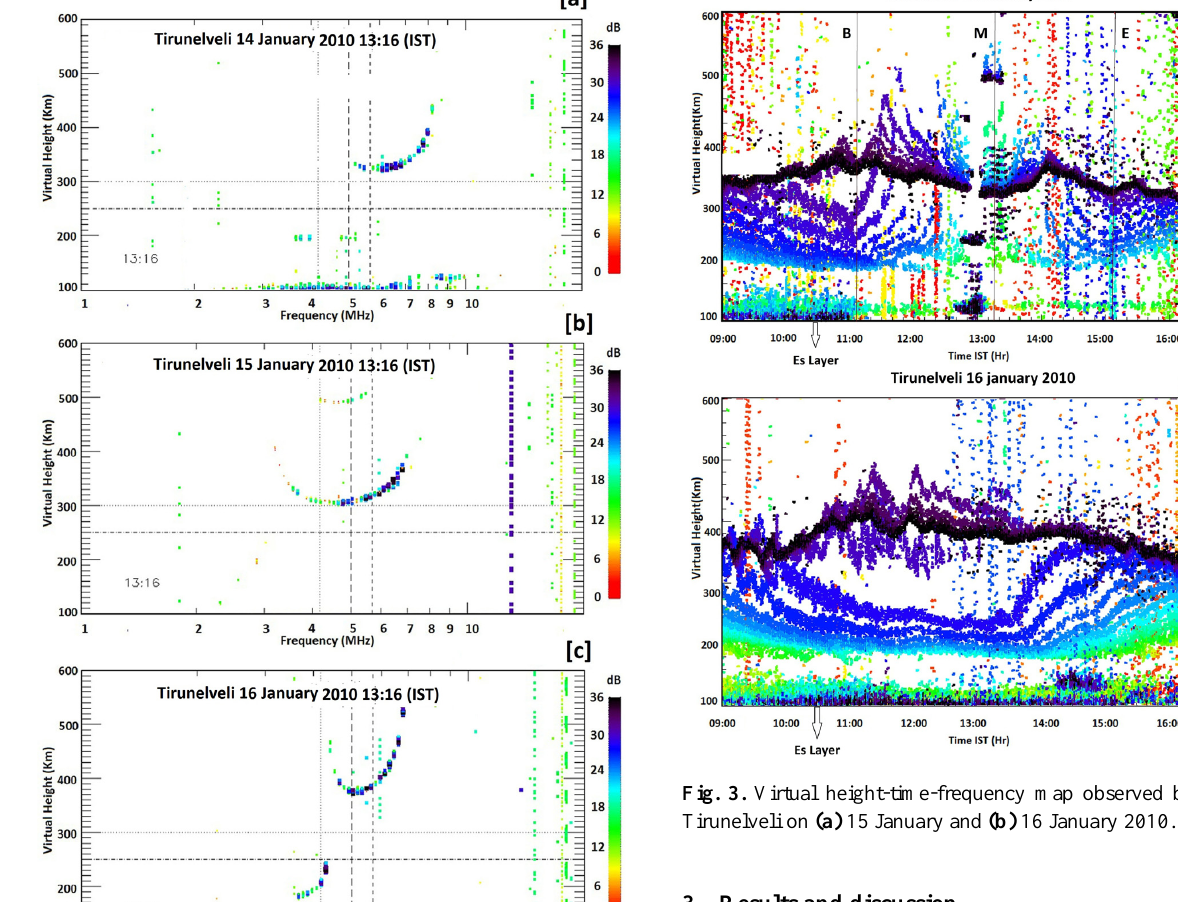
(i.e. fo F1, h 0 F1, fo F2, h 0 F2 and hm F2). For the control days, these parameters were further averaged for 30 min interval.